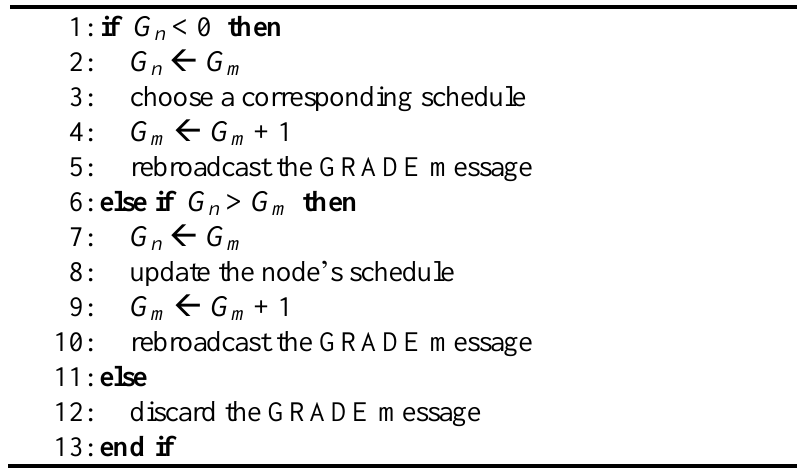
Algorithm 1. GDSA : processing the received GRADE